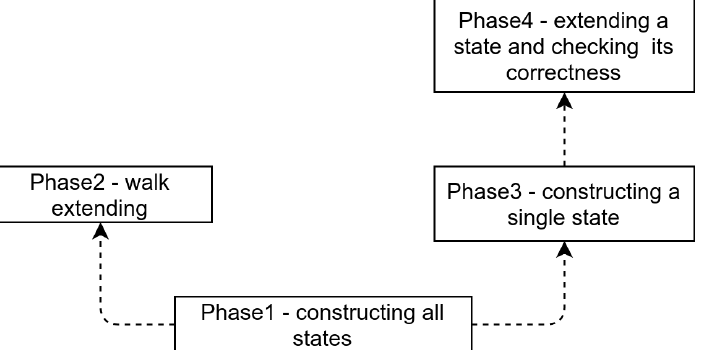
Figure 3. Diagram of relationships between phases of the algorithm. The direction of an arrow indicates the phase required by the phase from which the arrow